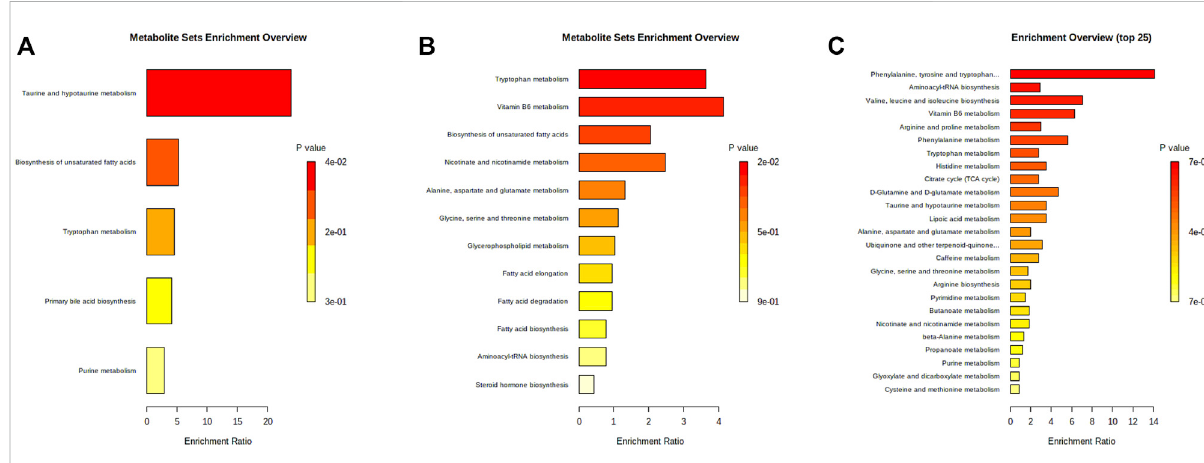
FIGURE 6 Bar charts of enrichment analysis based on the HK-attenuated PBs in serum (A) , kidney (B) , and urine (C)